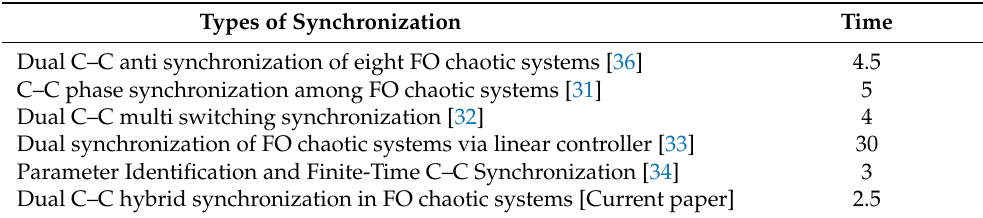
Table 1. A Comparison Analysis of the current paper with previously published